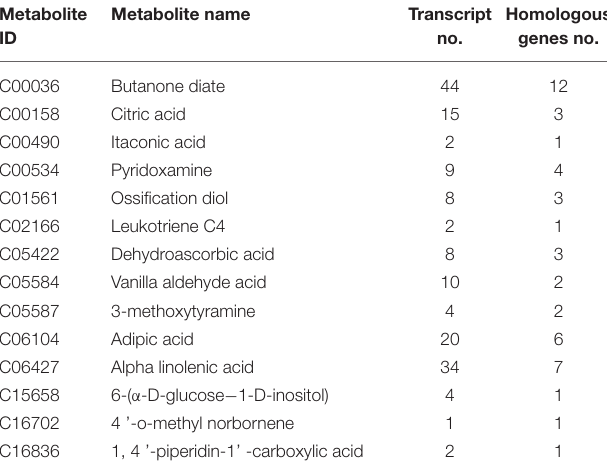
TABLE 3 | Joint analysis results of pituitary metabolites and transcripts in